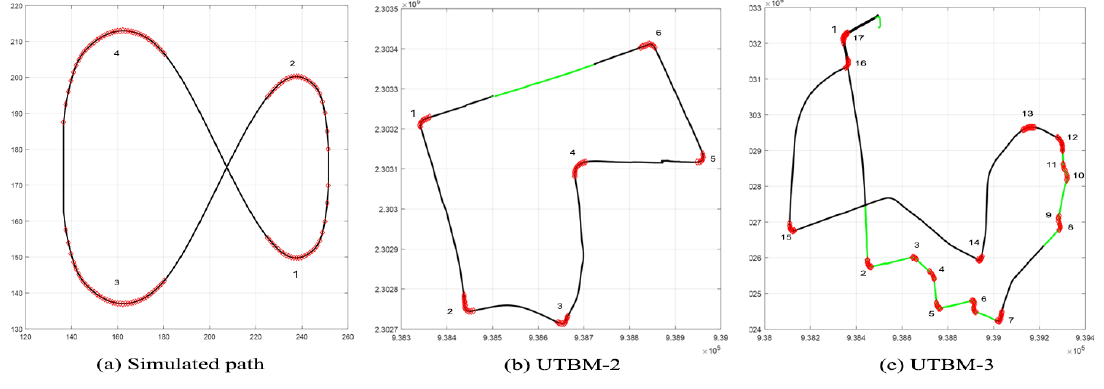
Figure 11. Datasets with sharp curves and speed limits marked. The normal black line represents a speed limit of 50 km/h, the green line a speed limit of 30 km/h and the sharp curves in